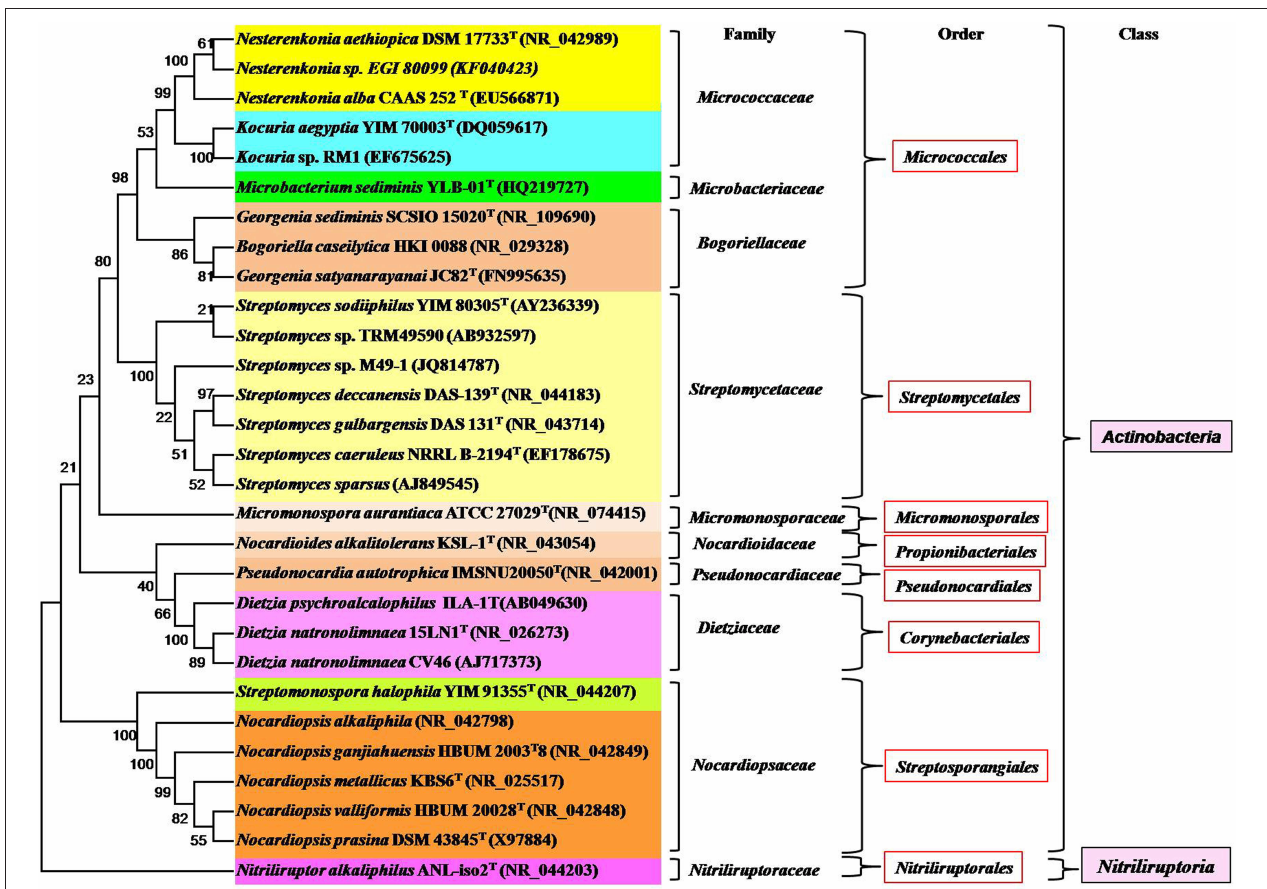
FIGURE 2 | Phylogram indicating the placement and relatedness of some alkaliphilic, alkalitolerant, alkalithermophilic and alkalithermotolerants actinobacterial strains belonging to two classes ( Actinobacteria and Nitriliruptoria ) of the phylum Actinobacteria . The numbers given at branch nodes indicate (%) bootstrap value. Bar 0.02 substitutions per 100 nucleotide